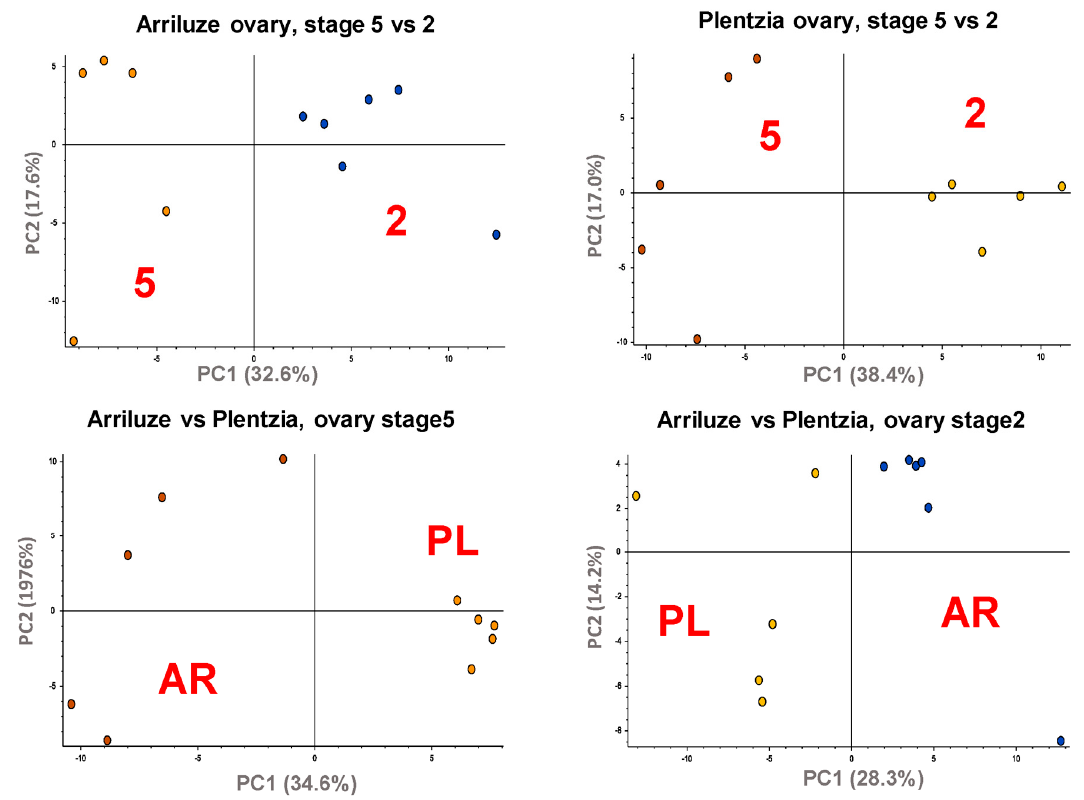
Figure 4. Principal component analysis (PCA) for pairwise comparison of metabolomic profile di ff erences in the mantles of sample groups. PCAs cluster mantle samples according to the site or sampling (PL versus AR), and maturity stage within each sex (2 versus